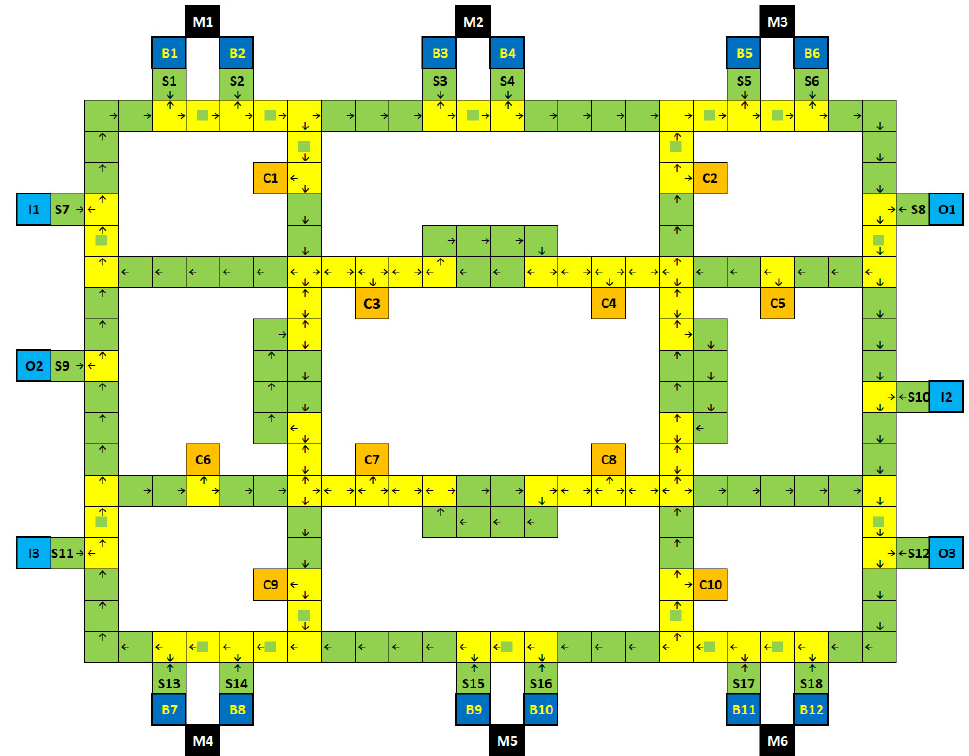
Figure 7. The layout with mixed flow